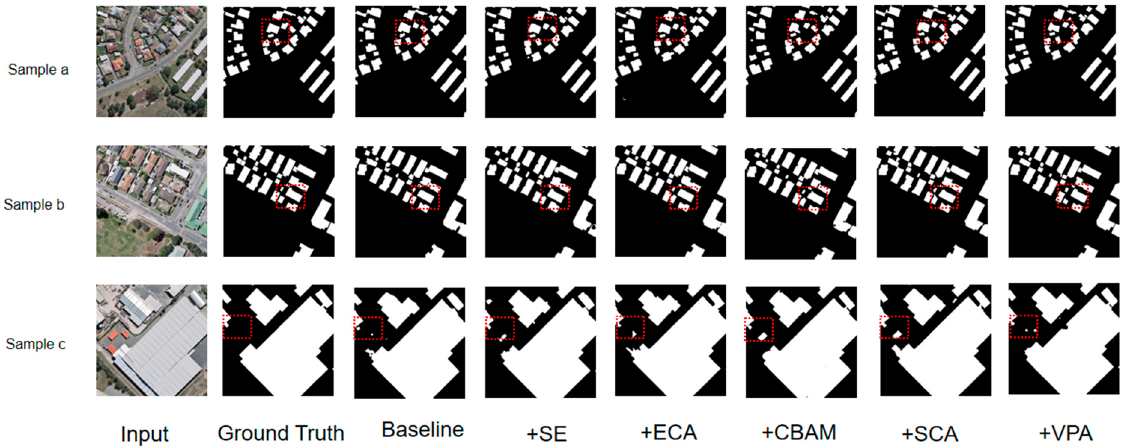
Figure 8. Comparison of prediction samples on the WHU Building dataset. The red dashed